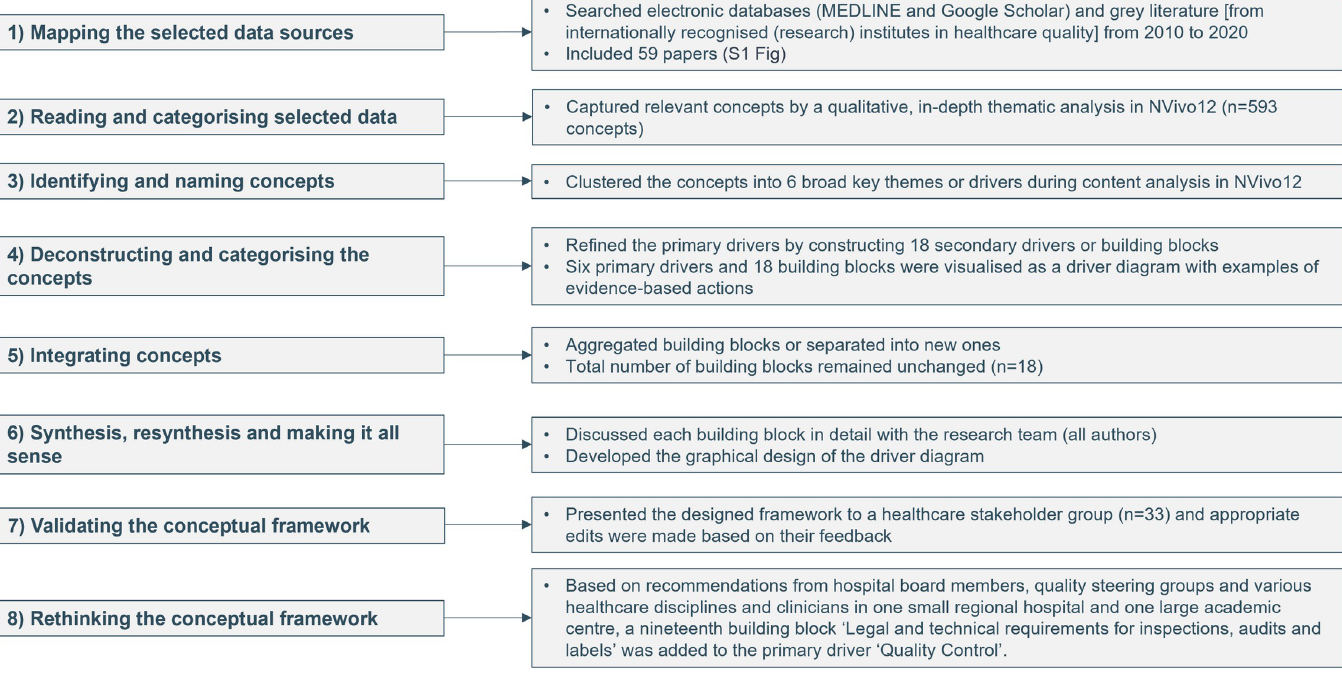
Fig 1. Eight-phase framework development